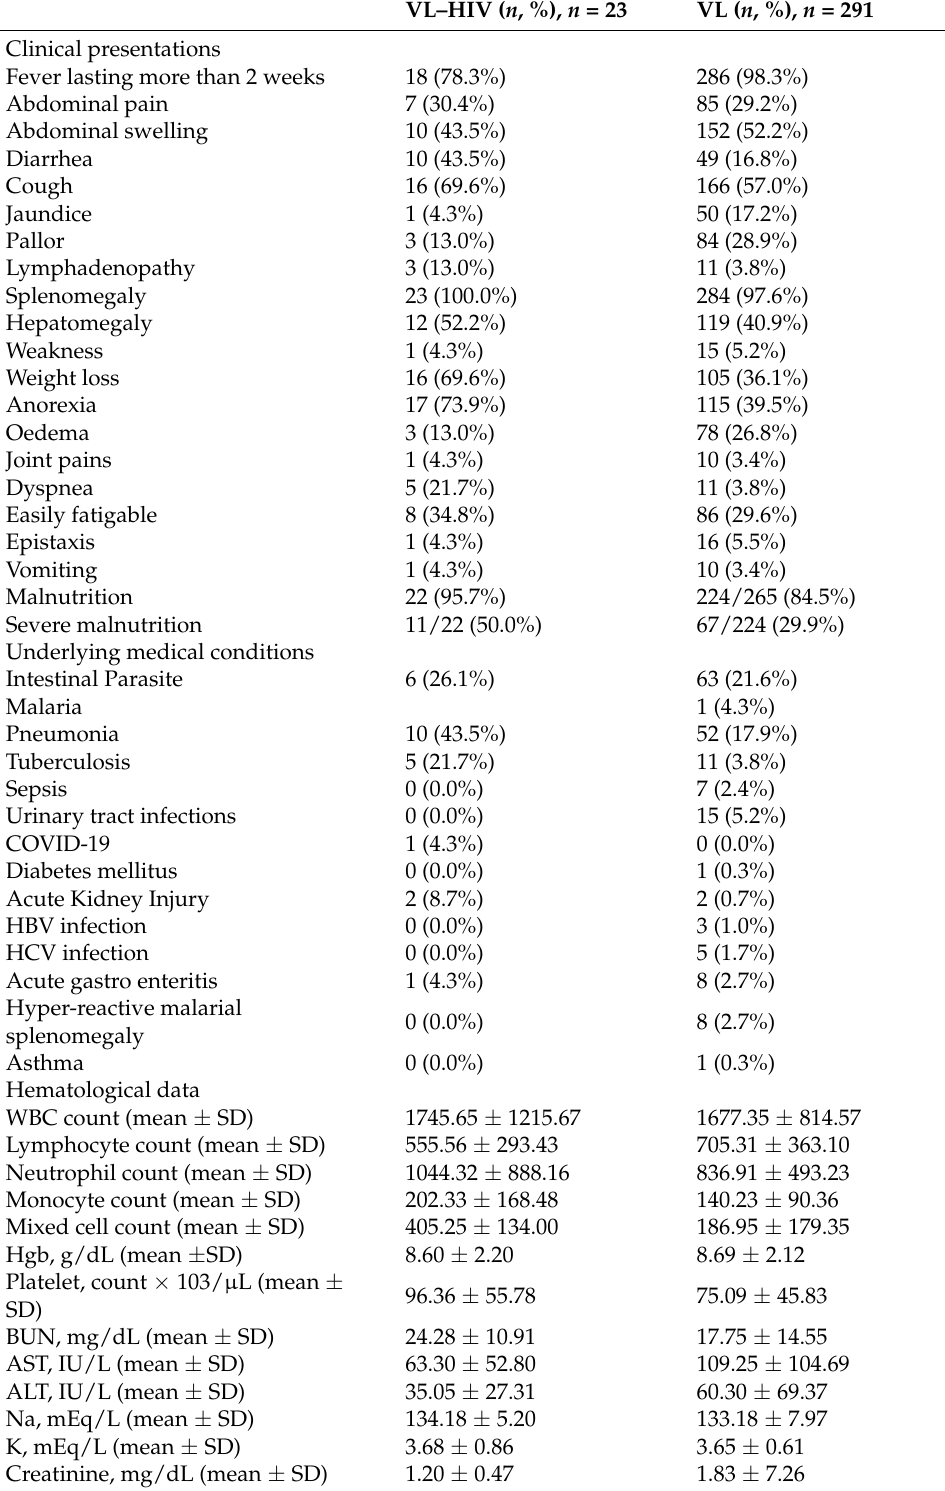
Table 2. Clinical presentations, underlying medical conditions, and hematological data among VL patients with and without HIV coinfection at the time of admission at the LRTC, Gondar, Ethiopia. VL–HIV ( n , %), n =